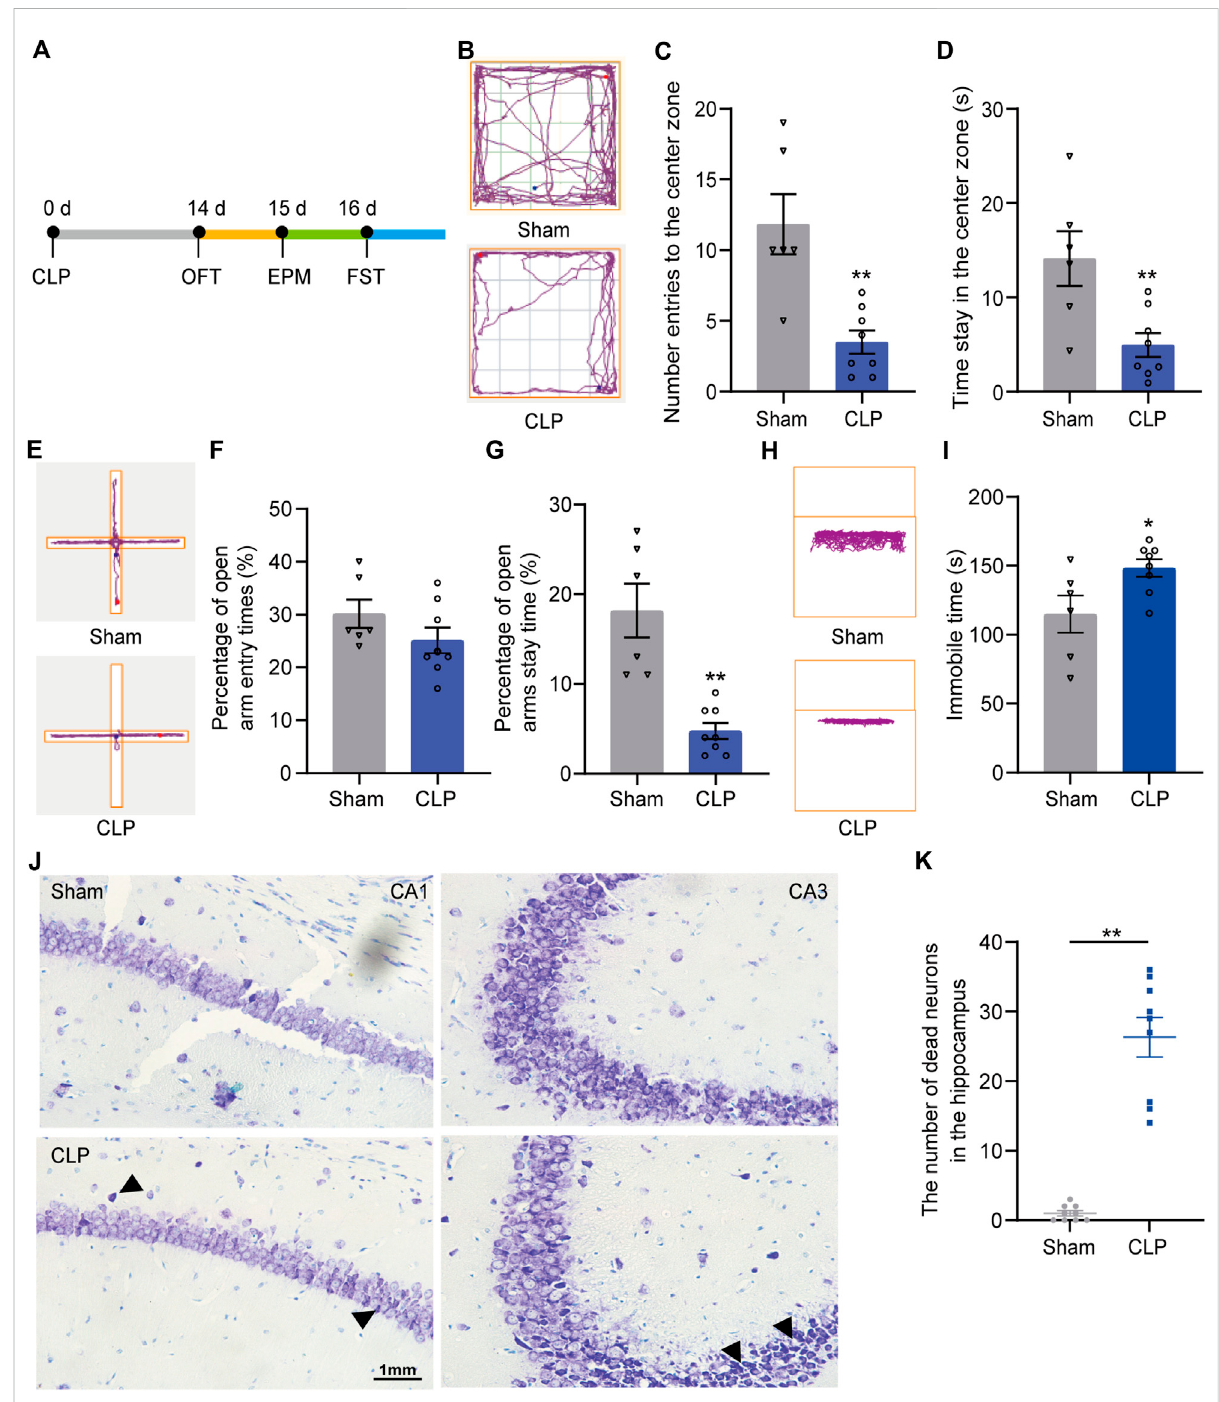
FIGURE 1 Septic mice showed long-term depression-like behaviors followed by loss of neurons in the hippocampus. (A) . An outline of the experimental procedure for mice with CLP surgery and behavioral tests. (B) . Typical tracking chart of the OPF between the sham and CLP. (C) . The differences between the sham and CLP in the number of entries to the center zone. (D) . The differences between the sham and CLP in time spent in the center zone in the OFT (n sham = 6, n CLP = 8). ** p < 0.01 vs. the sham. Data are shown as the mean ± SEM. (E) . Typical tracking chart of the EPM between the sham and CLP. (F) . In the EPM, percentage of entries to the open arms. (G) . Percentage of time spent in the open arms (n sham = 6, n CLP=8).** p < 0.01vs.theshamgroup.Dataareshownasthemean±SEM. (H) .TypicaltrackingchartoftheFSTbetweentheshamandCLP. (I) .Total immobility time during 5 min in the FST (n sham = 6, n CLP = 8). * p < 0.05 vs. the sham. Data are shown as the mean ± SEM. (J) . Nissl staining in the hippocampus of the sham and CLP 14 d after CLP. (K) . The number of dead neurons in the hippocampus between the sham and CLP. ** p < 0.01 vs. the sham. Data are shown as the mean ± SEM ( n =